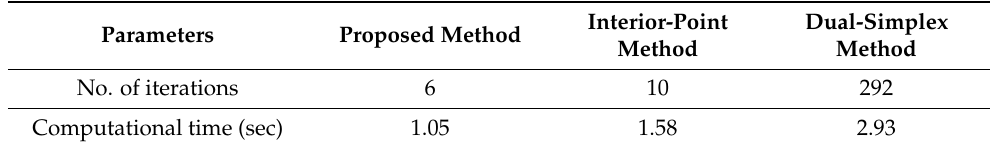
Table 4. Comparison of different